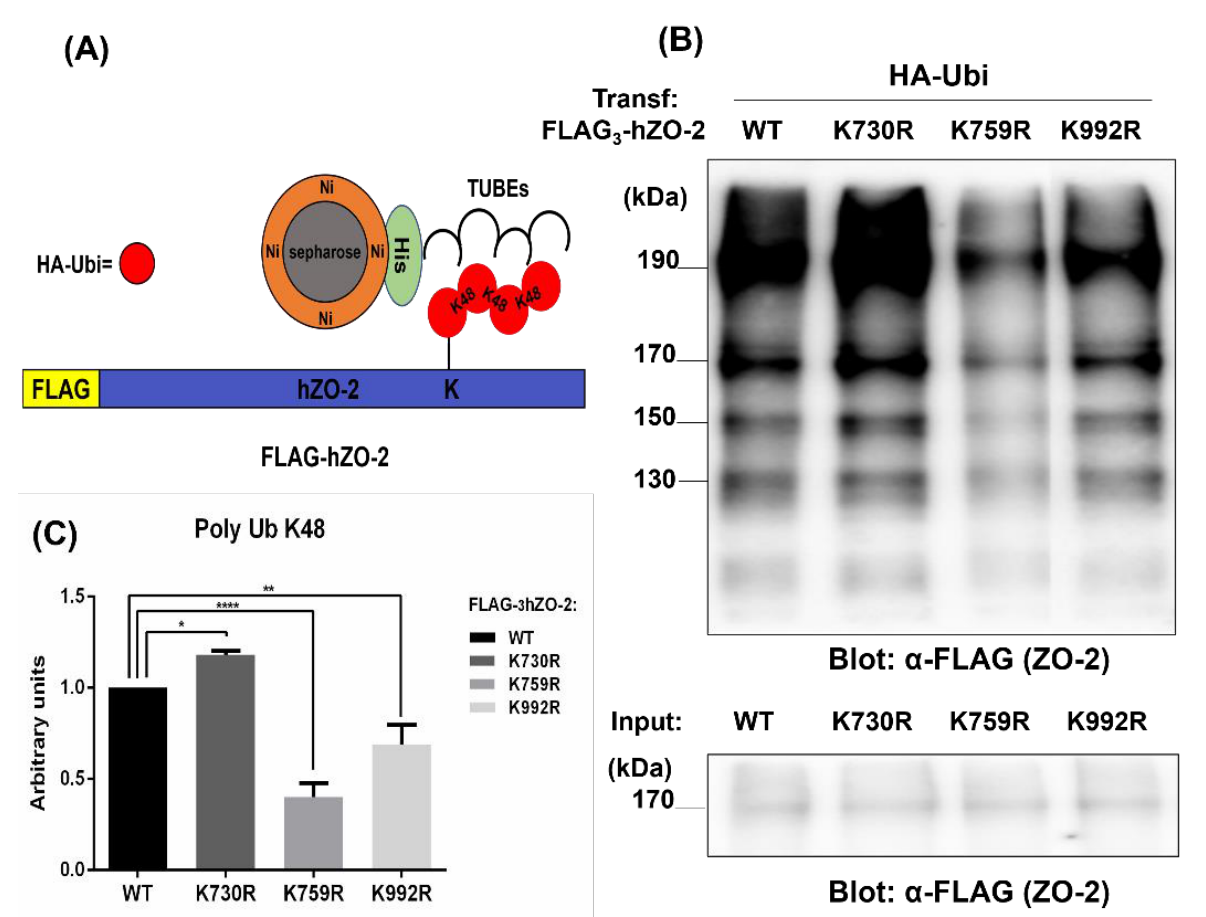
Figure 3. K48-poly-ubiquitination is increased in SUMOylation-defective hZO-2 mutant K730R and diminishes in hZO-2-K759R and K992R mutants. MDCK cells were co-transfected with HA-Ubi and Flag 3 -hZO-2 WT, and the ubiquitination mutants FLAG 3 -hZO-2-K759R or -K992R or the SUMOy- lation mutant FLAG 3 -hZO-2-K730R. After 24 h, the cells were lysed and treated with a His-tagged anti-K48 TUBE. K-48-poly-ubiquitinated proteins were purified with a His-tag affinity resin, run in an SDS-PAGE, and blotted against FLAG. ( A ) Schematic representation of Flag 3 -hZO-2 where K48- poly-ubiquitination associates to TUBEs that bind to a Ni 2+ -chelate matrix through a His-tag. ( B ) Representative Western blot of cell lysates. ( C ) Quantitative analysis of the area in the blot contain- ing the bands of 190, 170, 150, and 130 kDa. Data from three independent experiments. Statistical analysis was done with One-way ANOVA followed by Bonferroni ’ s multiple comparison test; ns, non-significant, * p < 0.05, ** p < 0.01, **** p < 0.0001.